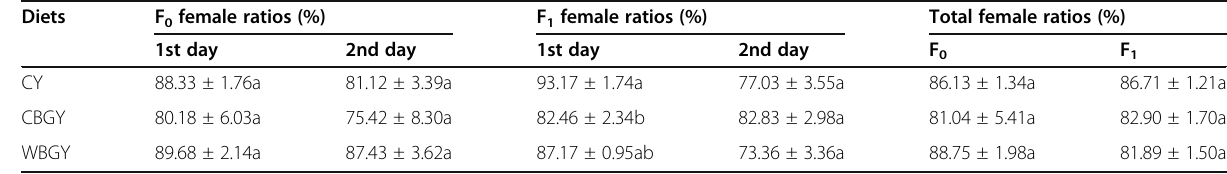
Table 8 Female ratios of Trichogramma evanescens parasitizing eggs of Ephestia kuehniella fed on three different diets Diets F 0 female ratios (%) F 1 female ratios